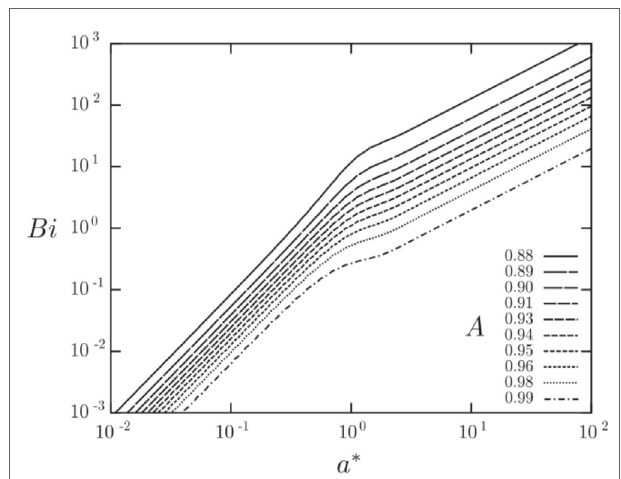
FiGURe 13 | Combination of the augmentation plots in Figures 12 into a single map . Reproduced with permission from Mathie and Markides (2013).